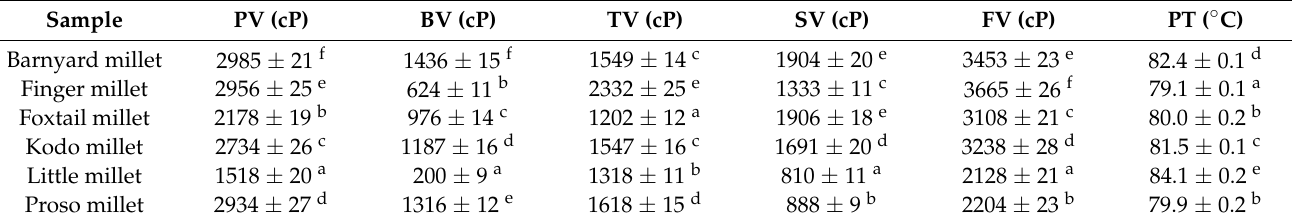
Table 2. Pasting characteristics of millet starches.